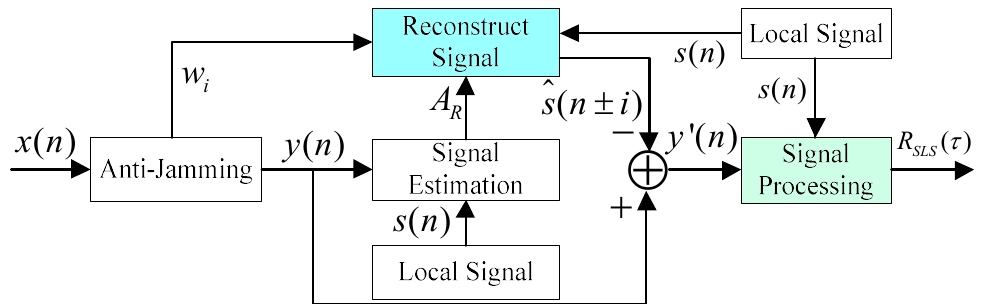
The block diagram of sidelobes suppression is shown in Figure 11.